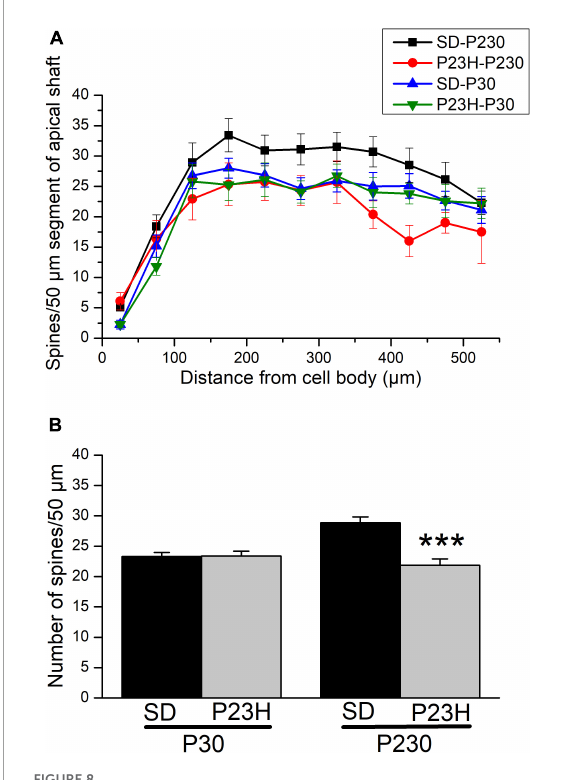
FIGURE8 Distribution and spine density along the apical shafts of the layer V pyramidal neurons of the visual cortices of the SD and P23H rats at P30 and P230. (A) Dendritic spine distribution along the apical shafts. An increase in the number of spines occurs with age, but only in the control SD rats. The spine distribution in the P23H-P230 rats was closer to that observed in both groups of young P30 rats. A significant decrease in the number of spines was observed in the P23H-P230 rats vs. SD-P230. The two-way ANOVA showed at P230 that these differences were statistically significant (*** p < 0.001). (B) Mean number of dendritic spines/50 µ m in the apical shafts. At P30, no differences were found between the mean number of dendritic spines/50 µ m between the SD and P23H rats. At P230, a significant decrease in the number of spines in the P23H animals is observed vs. SD ( p < 0.001; Mann-Whitney U